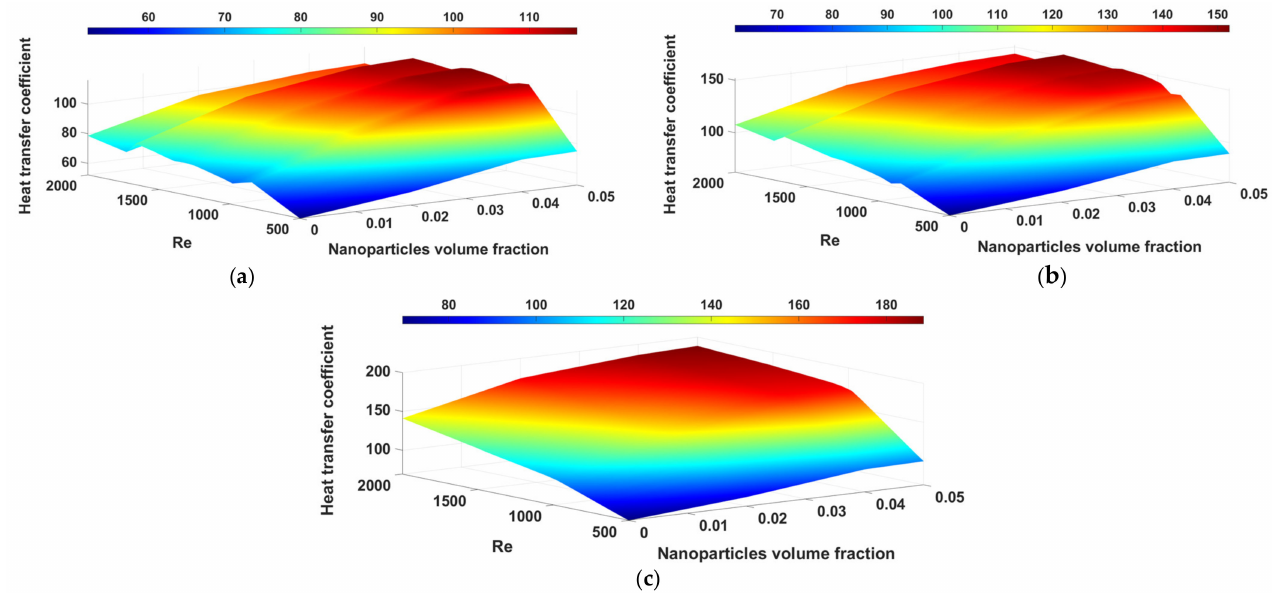
Figure 6. Heat transfer coefficient versus Reynolds number, nanoparticle volume fraction, and channel turns number: ( a ) 4 turns, ( b ) 6 turns, and ( c ) 8 turns—results for each subfigure were obtained from 20